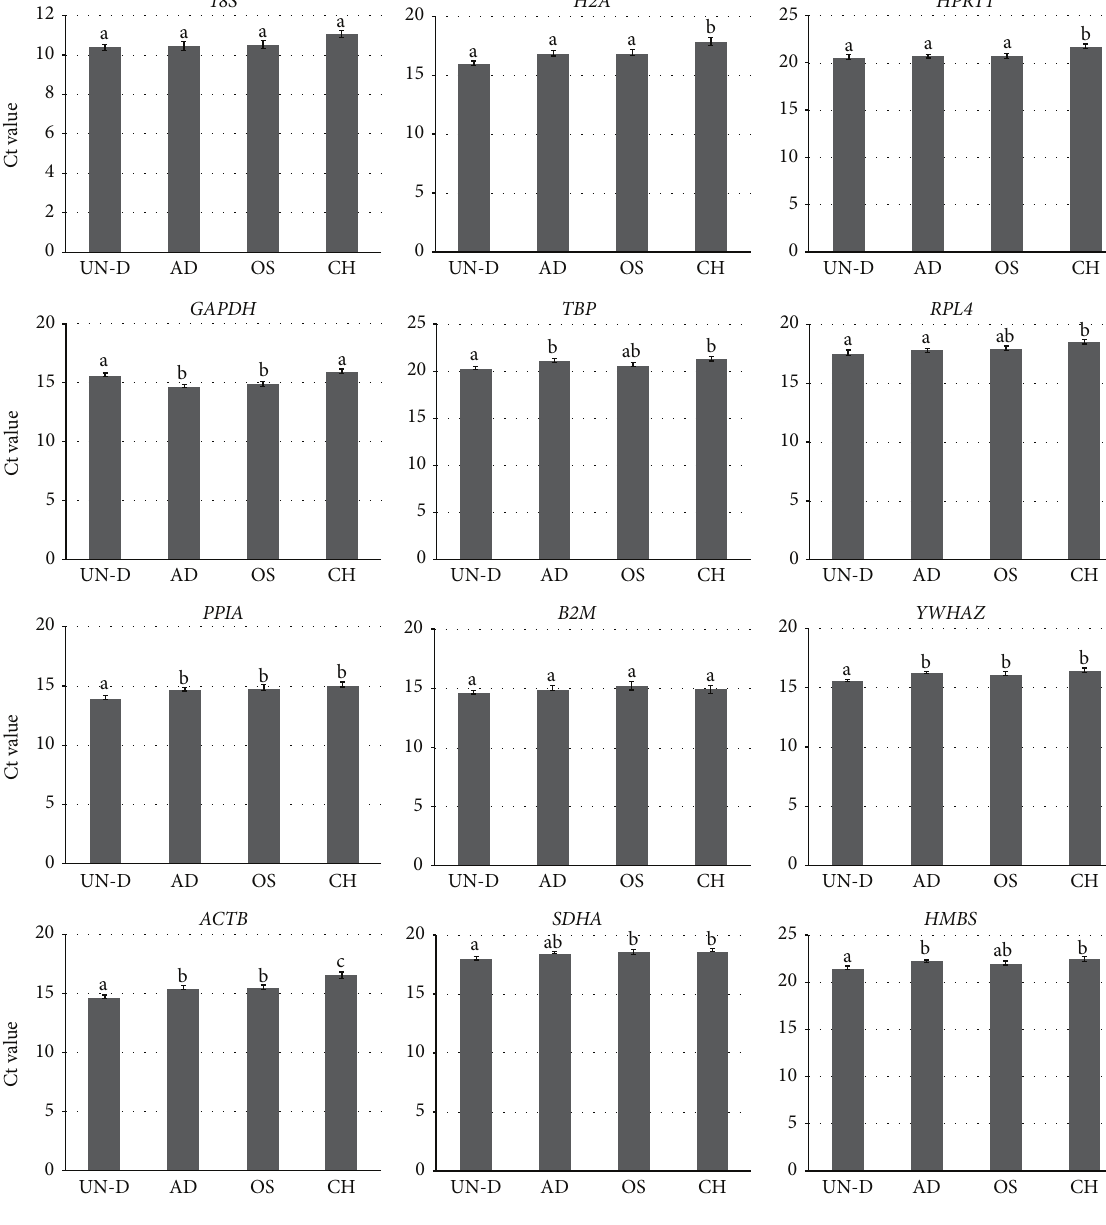
Figure 4: Average of Ct values in selected reference genes under various MSCs status. The Ct value of each primer was analyzed by ANOVA with Turkey’s post hoc test. Significant differences were displayed by letters in the top of bars ( 𝑃 < 0.05 ). Graphs were presented as mean ±